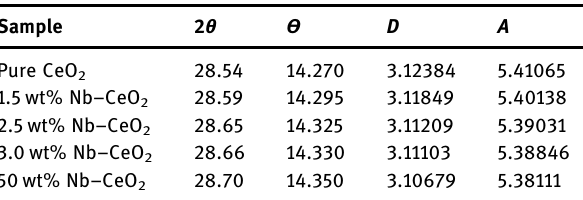
Table 2: Inter - plane spacing and lattice parameters of the prepared samples